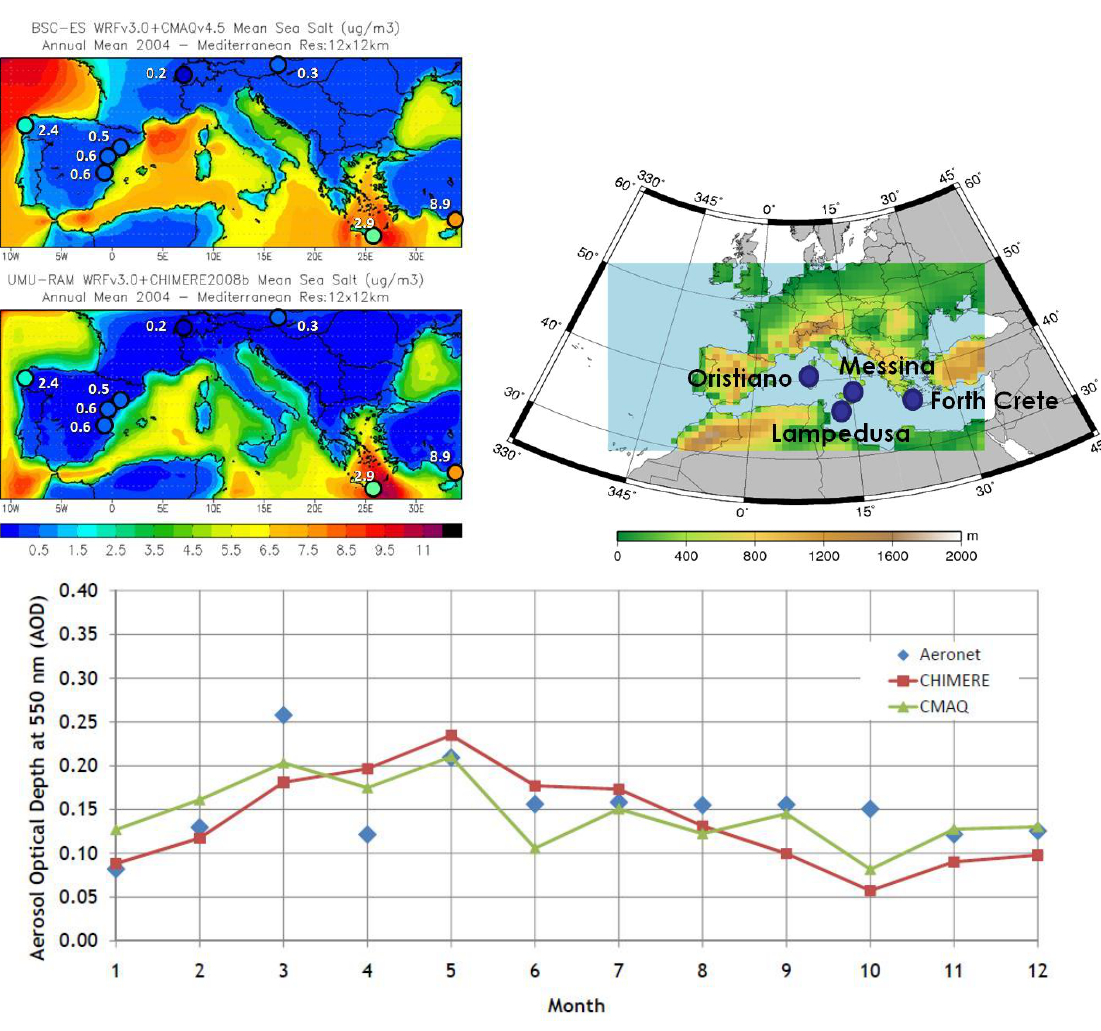
Fig. 2. (Up, left) Modeled annual mean SSA concentration ( µ g m − 3 ) for WRF+CMAQ (top) and WRF+CHIMERE (bottom) simulations. Filled circles indicate the concentrations at the stations reported by Querol et al. (2009); (Up, right) Location of the Aeronet stations used in this work for evaluation; (Down) Average results of Aerosol Optical Depth for Aeronet stations (blue diamonds), CHIMERE (red line) and CMAQ (green line). The numerical results of the statistical evaluation are shown in Table 2. 32